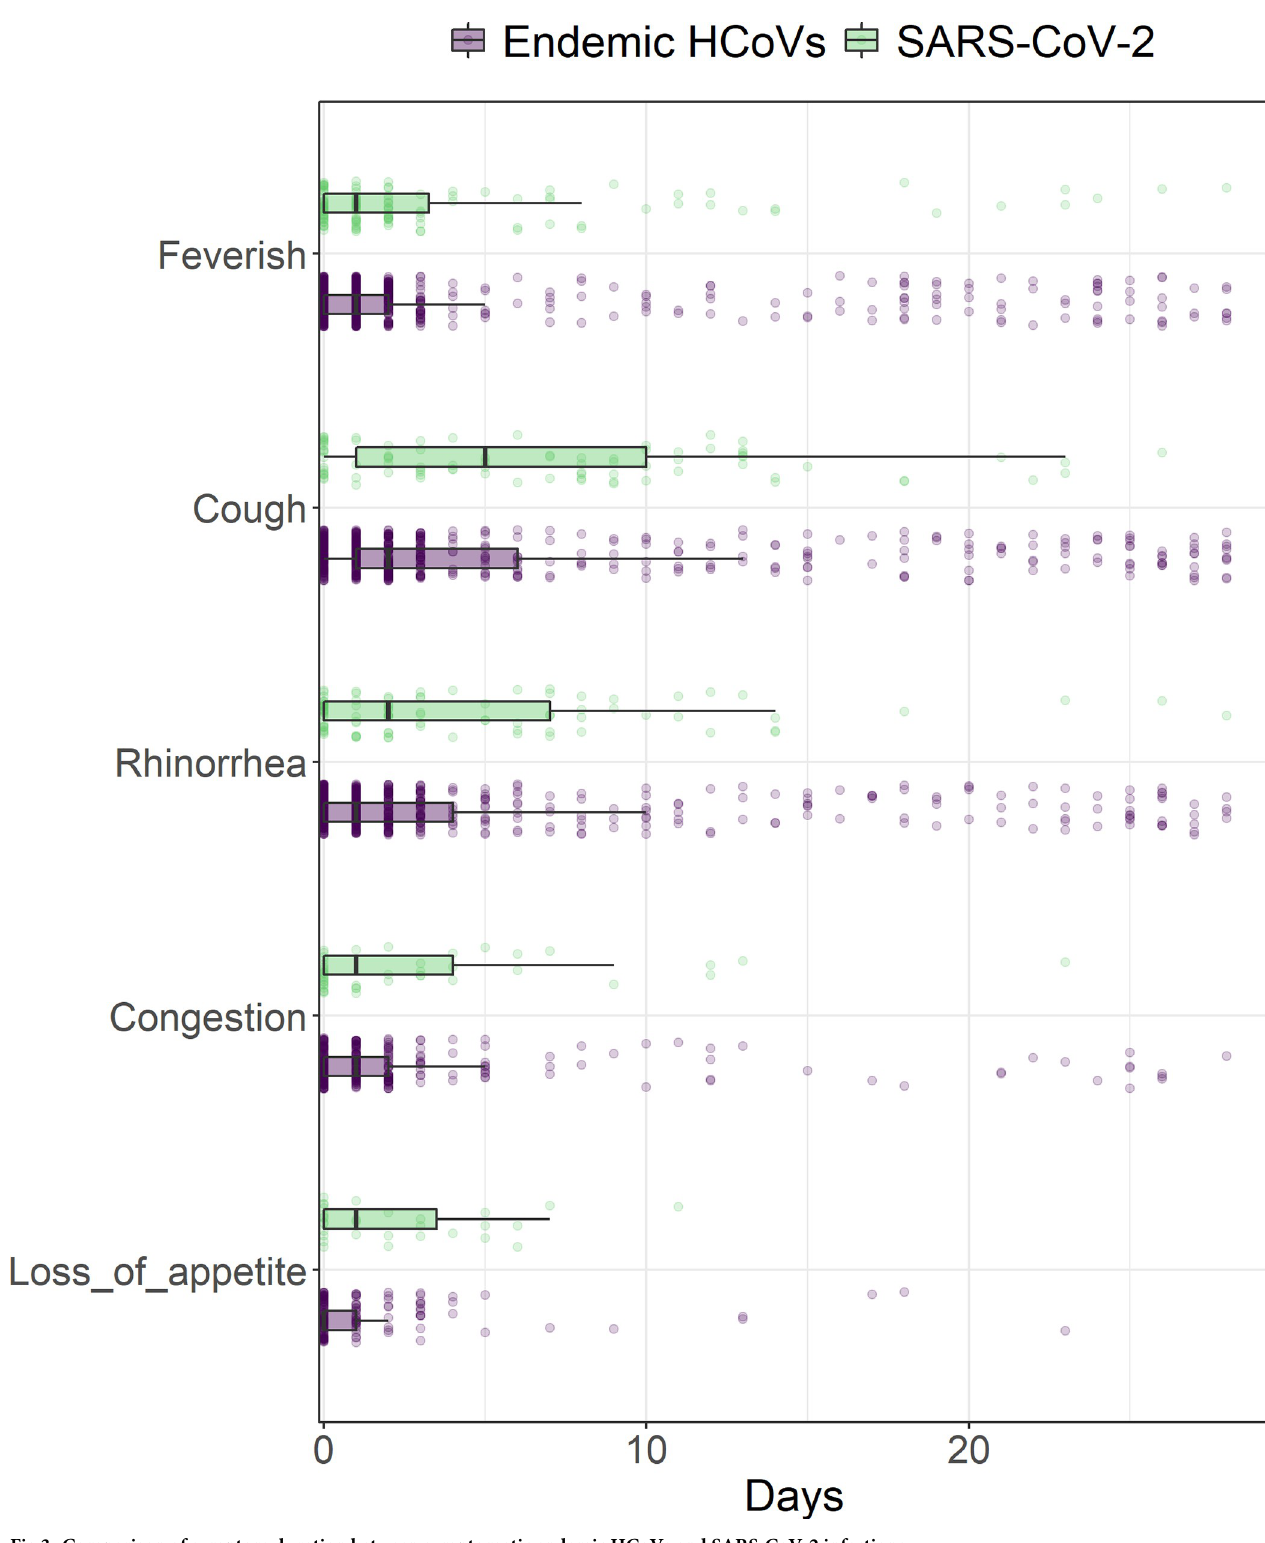
Fig 3. Comparison of symptom duration between symptomatic endemic HCoVs and SARS-CoV-2 infections.